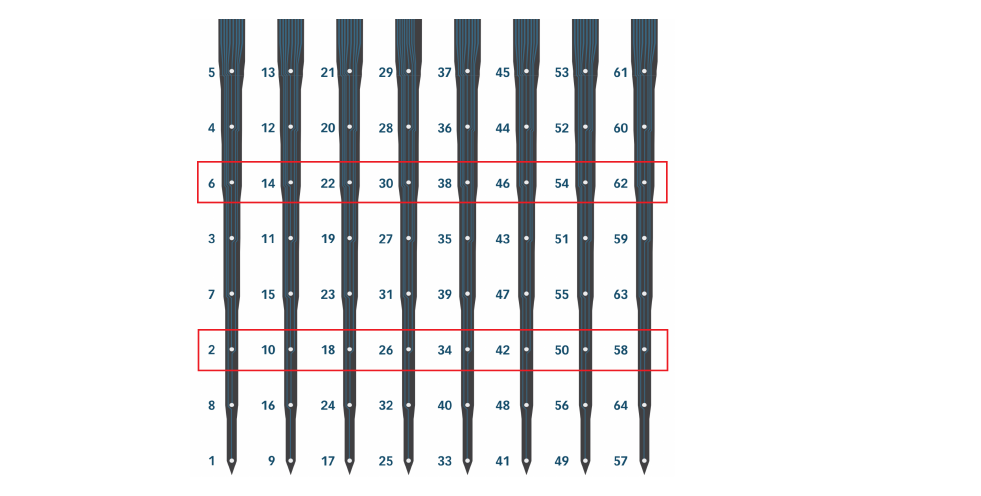
Figure 15. NeuroNexus A8x8 MEA scheme used for conducting described experiments. Numbers next to each electrode tell the manufacturer’s electrode identifier. Red rectangles indicate MEA sites used for described experiments involving Neurostim-3 ASIC current stimulation